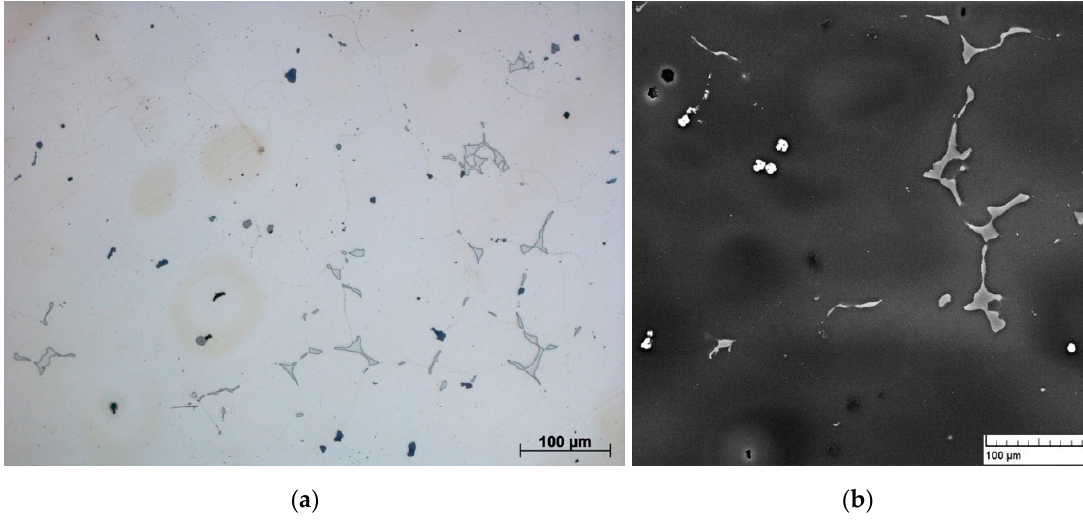
Figure 4. Microstructure of the AZ61 alloy after heat treatment. ( a ) Light micrograph. ( b ) Electron micrograph. Picric acid was used for etching.